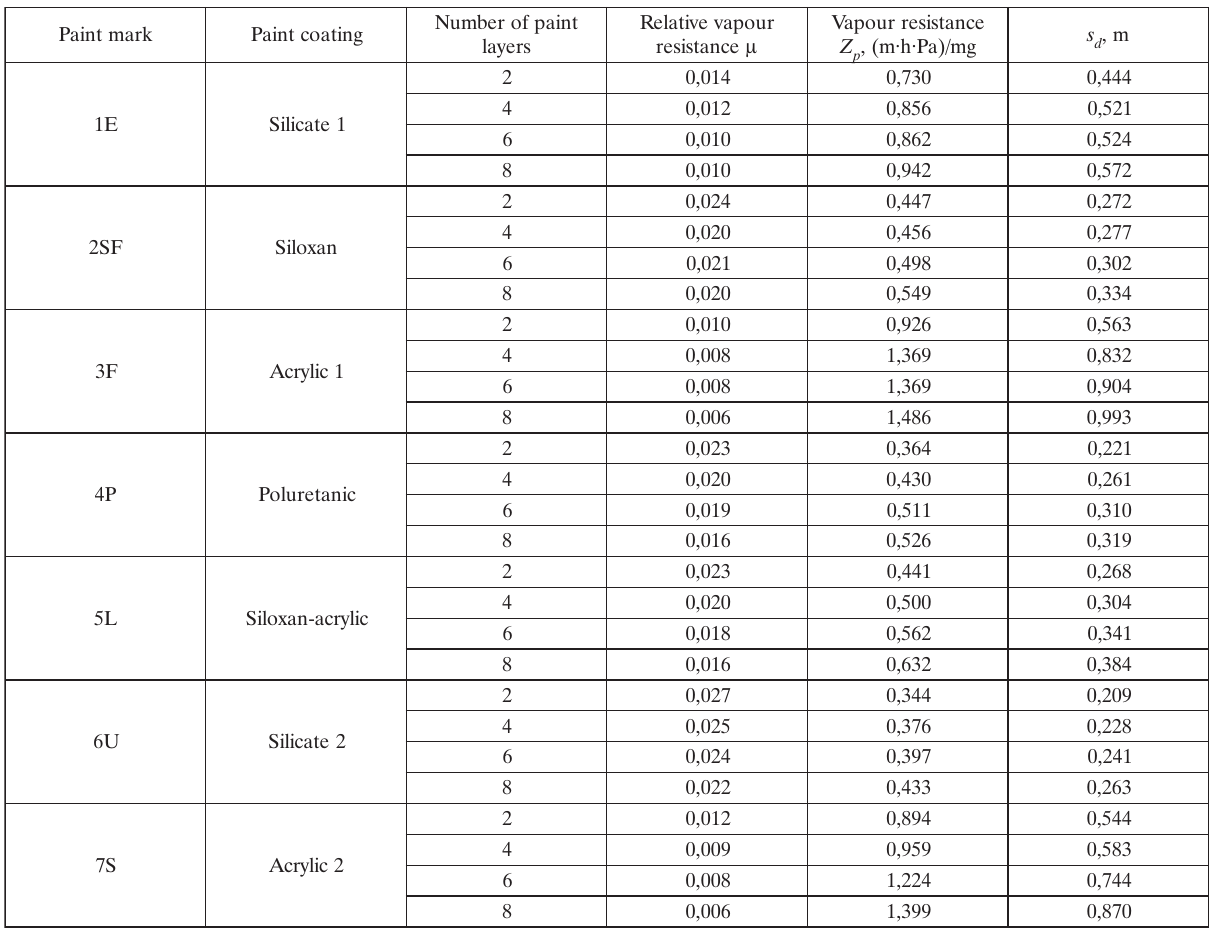
Table 4. Values of vapour permeability of the mineral thin render-paint coating system by considering the number of coatings